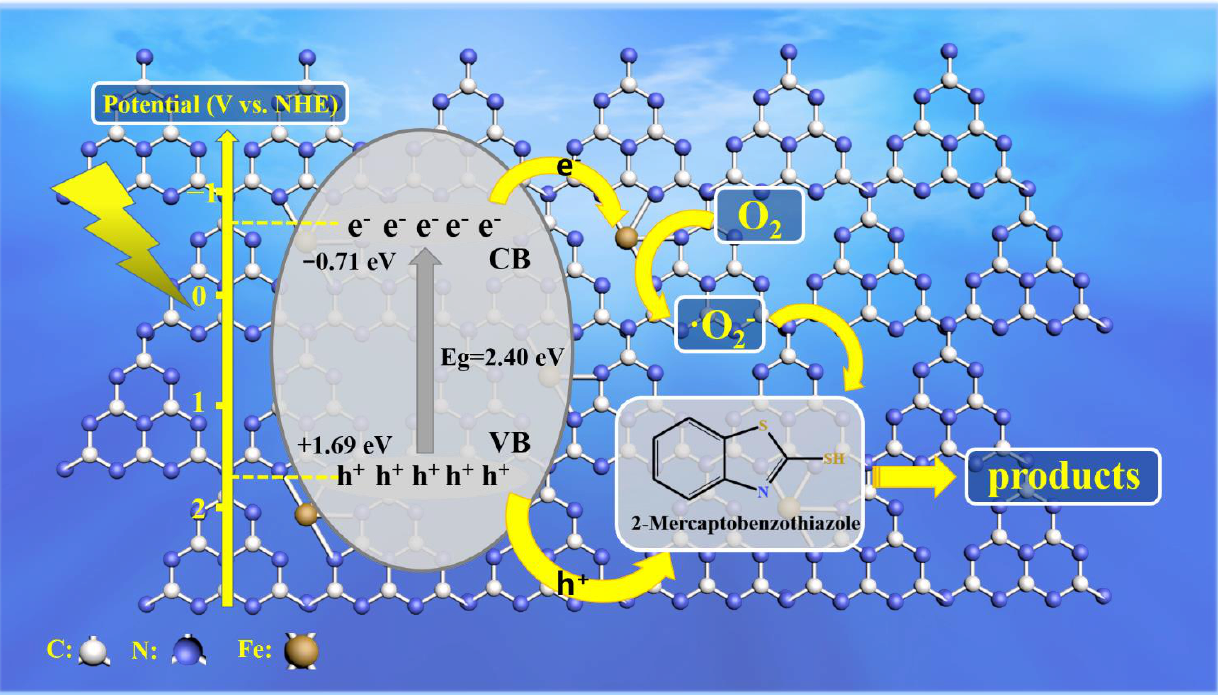
Figure 10. Schematic illustration of proposed catalytic mechanism in the Fe-SACs/g-C 3 N 4